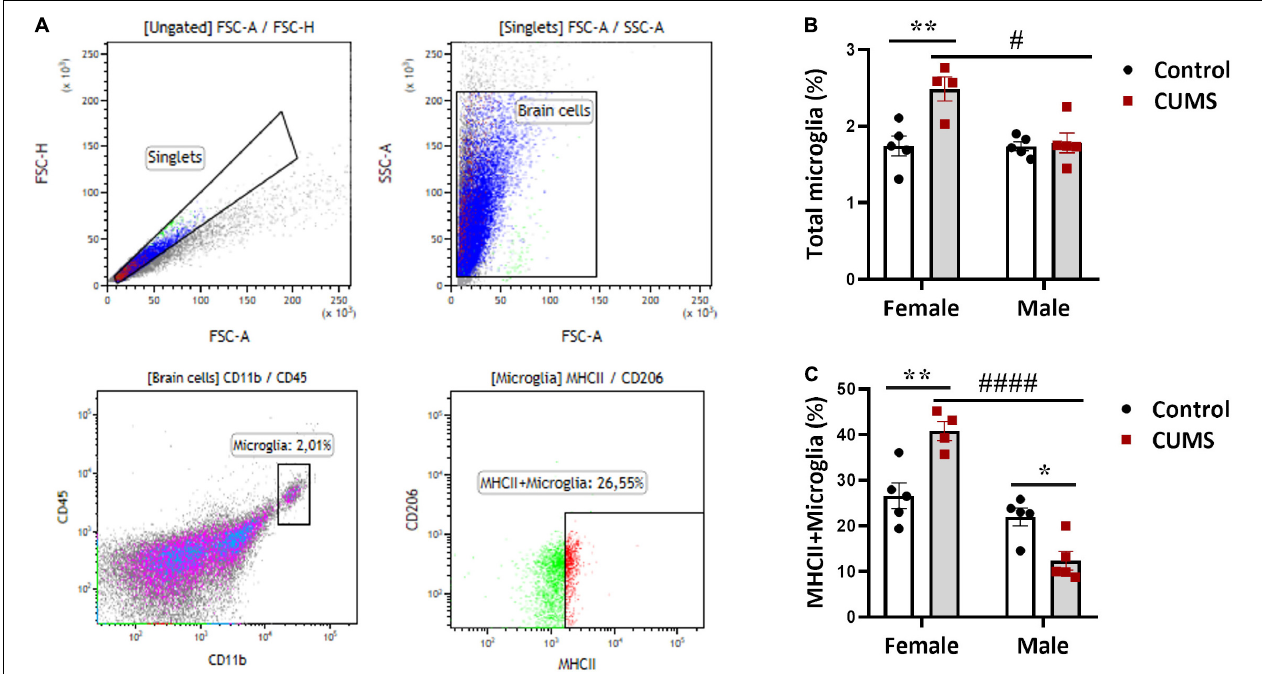
FIGURE 2 | Hippocampal microglia were activated in CUMS female mice. (A) Representative graphs showing gating strategy for astrocytes, OPCs, microglia, and MHCII + microglia; (B) percentage of microglia among total brain cells present in the hippocampus; (C) percentage of MHCII + microglia among total microglia. The symbols * and # represent CUMS and sex differences, respectively (two-way ANOVA). * p < 0.05, ** p < 0.01, # p < 0.05, and #### p <